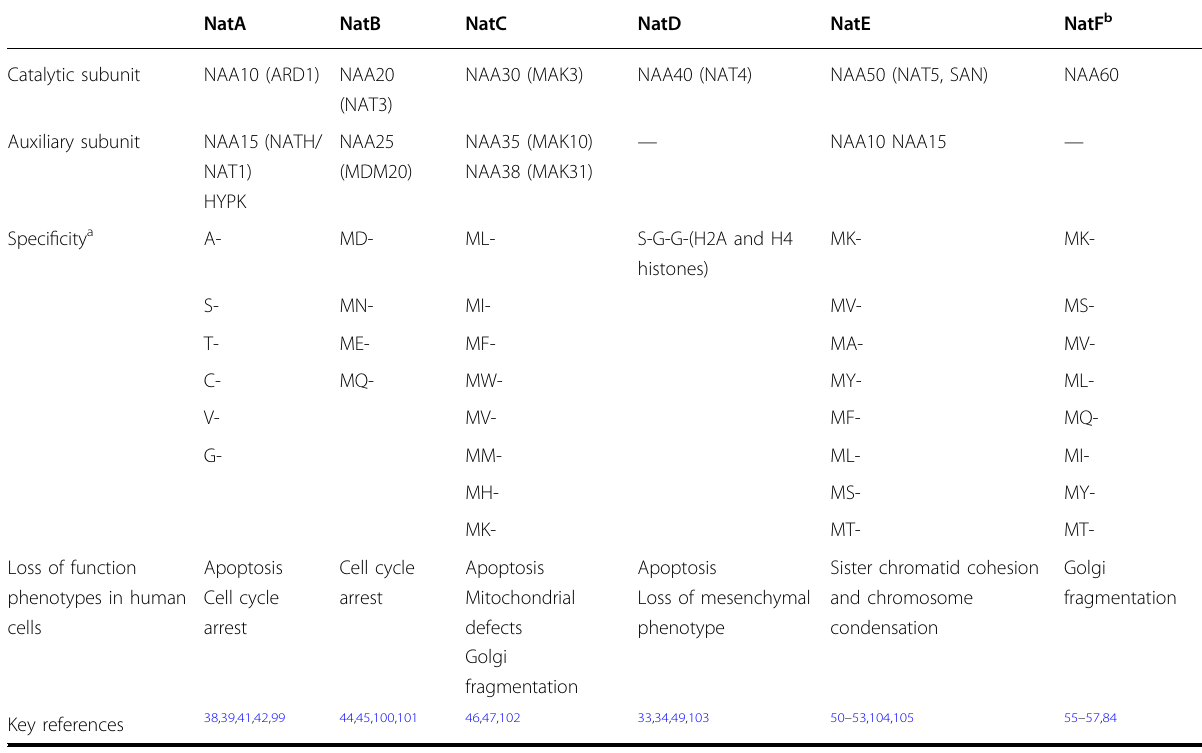
Table 1 Composition and substrate speci fi city of human